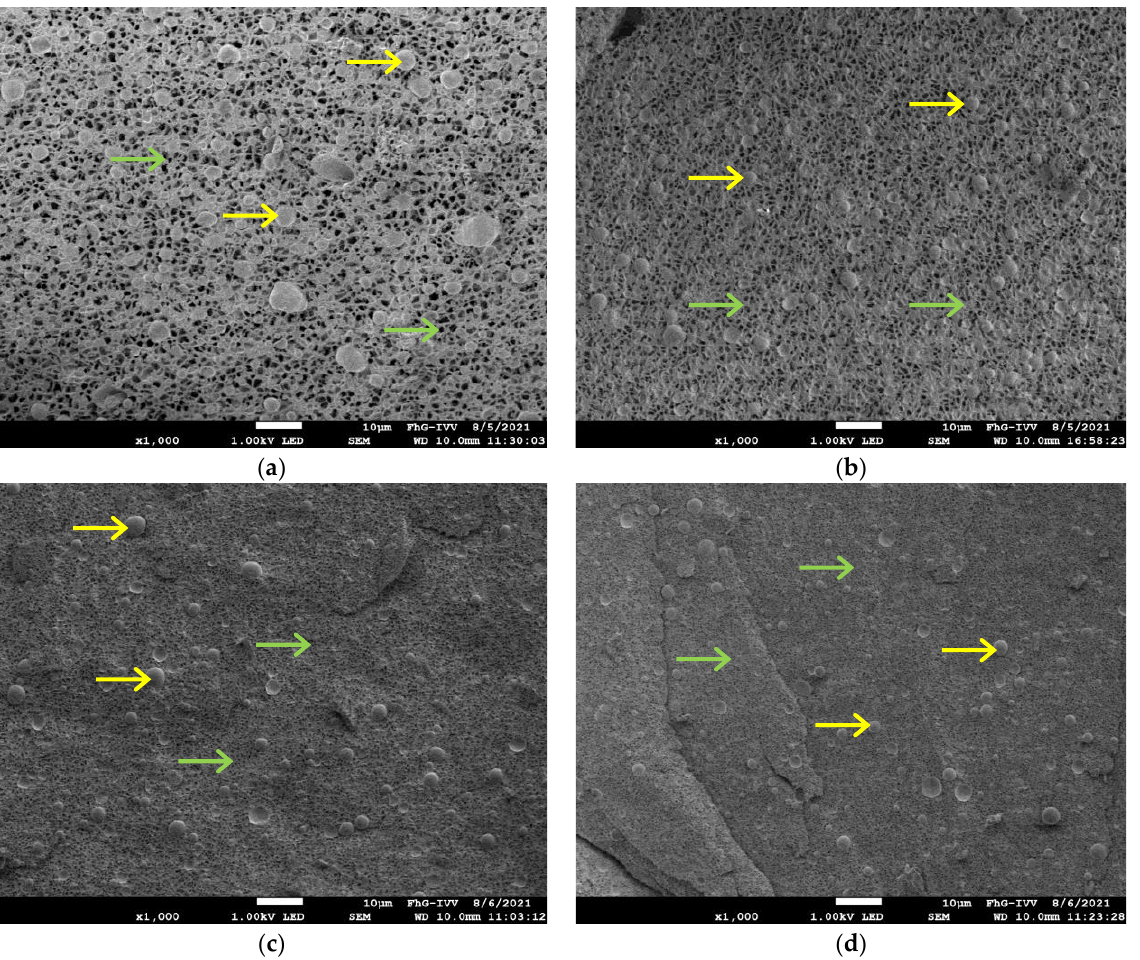
Figure 11. SEM pictures of the full-fat ( a ), 100 CD 50 ( b ), 50 CD 50 ( c ), and 0 CD 50 ( d ) samples. Fat droplets (yellow arrows), continuous network (green arrows). Magnitude 1000×, at 1.0 kV. Bar = 10 µm.